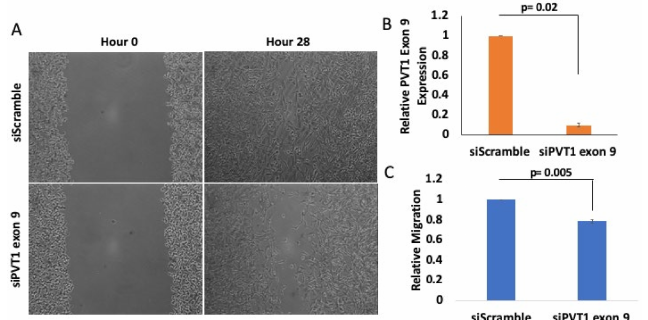
Figure 4. PVT1 regulates migration of MDA MB 231 CL TNBC cells. ( A ) Wound healing migration assays were performed with the MDA MB 231 CL TNBC cell line. MDA MB 231 cells were transfected once confluent. After 24 h, wounds were made and monitored between 0 h and 28 h. Images were taken at 10x magnification using Motic AE30 imaging software. ( B ) Knockdown of PVT1 exon 9 expression in the MDA MB 231 CL TNBC cell line at hour 0. Transfection of SiRNAs that specifically target PVT1 exon 9 was performed. Relative expression of PVT1 exon 9 in MDA MB 231 cells was assessed, based on data from 2 independent experiments. ( C ) Quantification of differences in migration, after 28 h, based on data from 3 independent